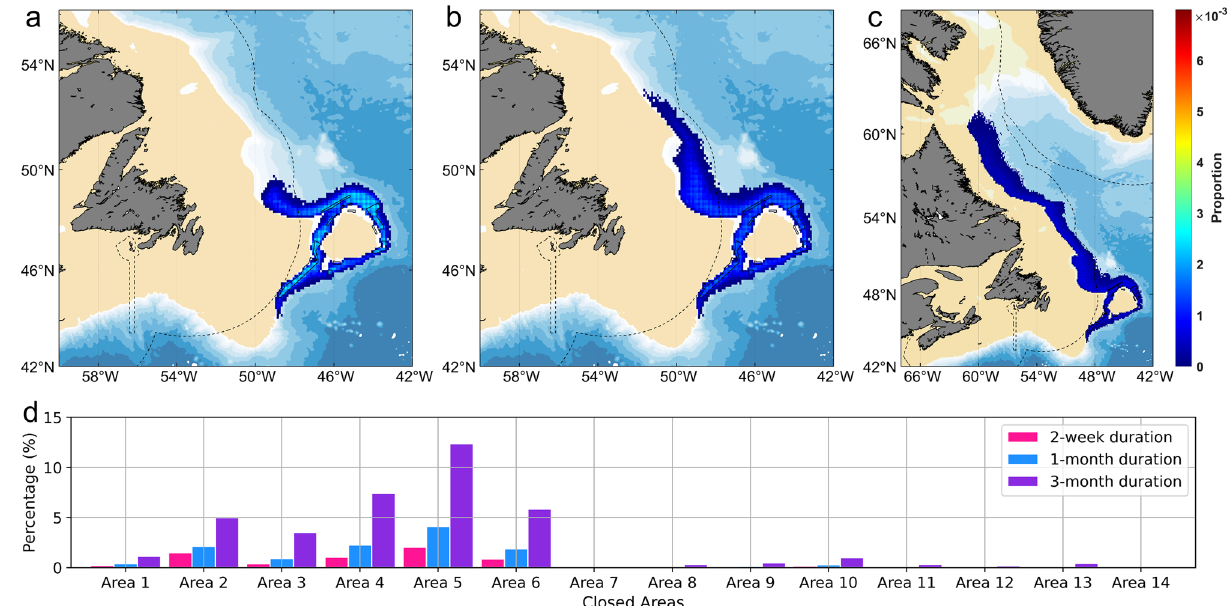
Figure 4. Potential source populations. Spatial distribution of the proportion of released particles ending in and passing over each 0.1° × 0.1° grid cell with particles released at 1000 m depth and forward-tracked with drift durations of: ( a ) 2-week, ( b ) 1-month and ( c ) 3-month drift durations; ( d ) the proportion of released particles (1000 m) entering each closed area (see Fig. 1c) under three drift duration scenarios. Dashed lines indicate boundaries of national jurisdictions downloaded from the Maritime Boundaries Geodatabase, version 11, available online at https:// www. marin eregi ons. org/, https:// doi. org/ 10. 14284/ 382. The maps were generated using bathymetry and coastline data produced and made publically available by the NOAA National Centers for Environmental Information (NCEI). The ETOPO1 Ice Surface (https:// doi. org/ 10. 7289/ V5C82 76M) arc- minute global relief model of the Earth’s surface (https:// www. ngdc. noaa. gov/ mgg/ global/) was used to generate bathymetry and the Global Self-consistent, Hierarchical, High-resolution Geography Database